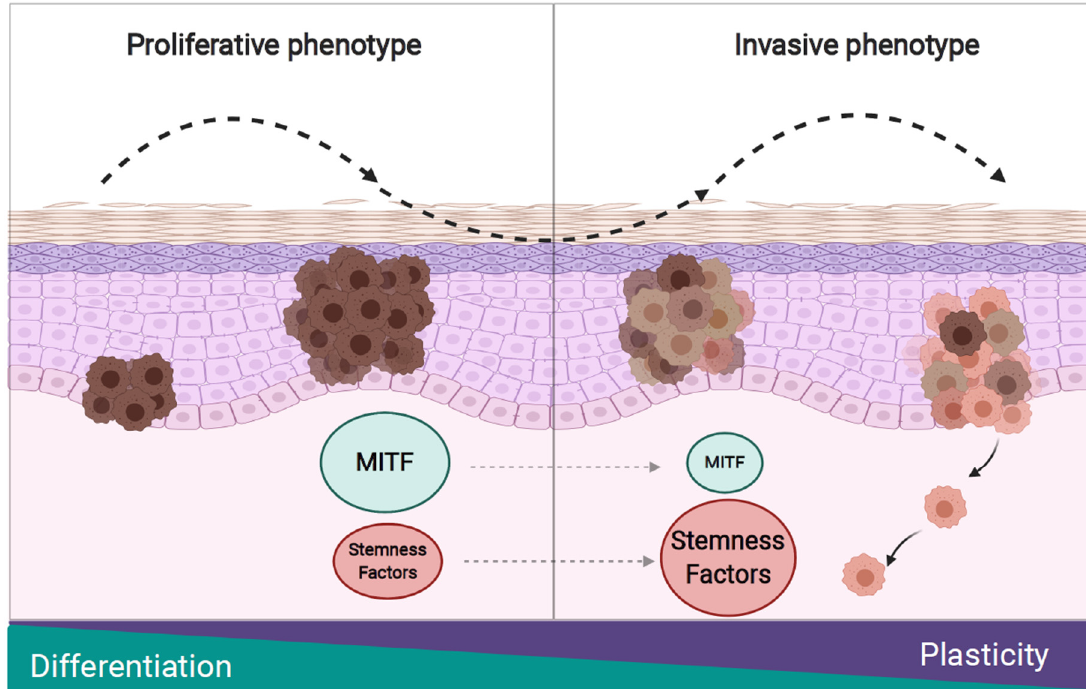
Figure 3. Cellular plasticity in melanoma. Melanoma cells can switch between a differentiated / proliferative and a dedifferentiated / invasive phenotype. This phenotype switch increases plasticity and is responsible for a poor response to treatments. Microphthalmia-associated transcription factor (MITF) is the main factor that drives the melanoma phenotype switch and its expression correlates with each specific phenotype. Additionally, the expression of stemness-related factors has been associated with the invasive phenotype and goes along with an increase in aggressiveness and plasticity of the tumors.